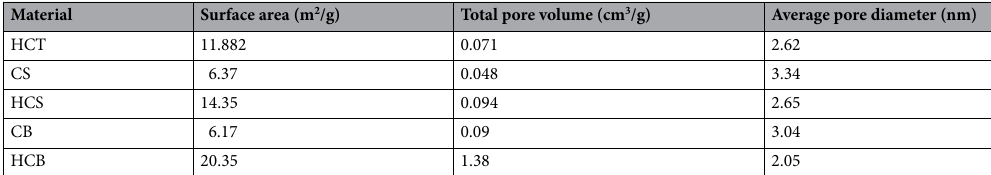
Table 8. BET analysis results of the coals, produced HCs and AC. CT coal tailing, CS coal slurry, CB blend of coals and sewage sludge, HCT coal tailing’s hydrochar, HCS coal slurry’s hydrochar, HCB hydrochar form CB, BET Brunauer Emmet